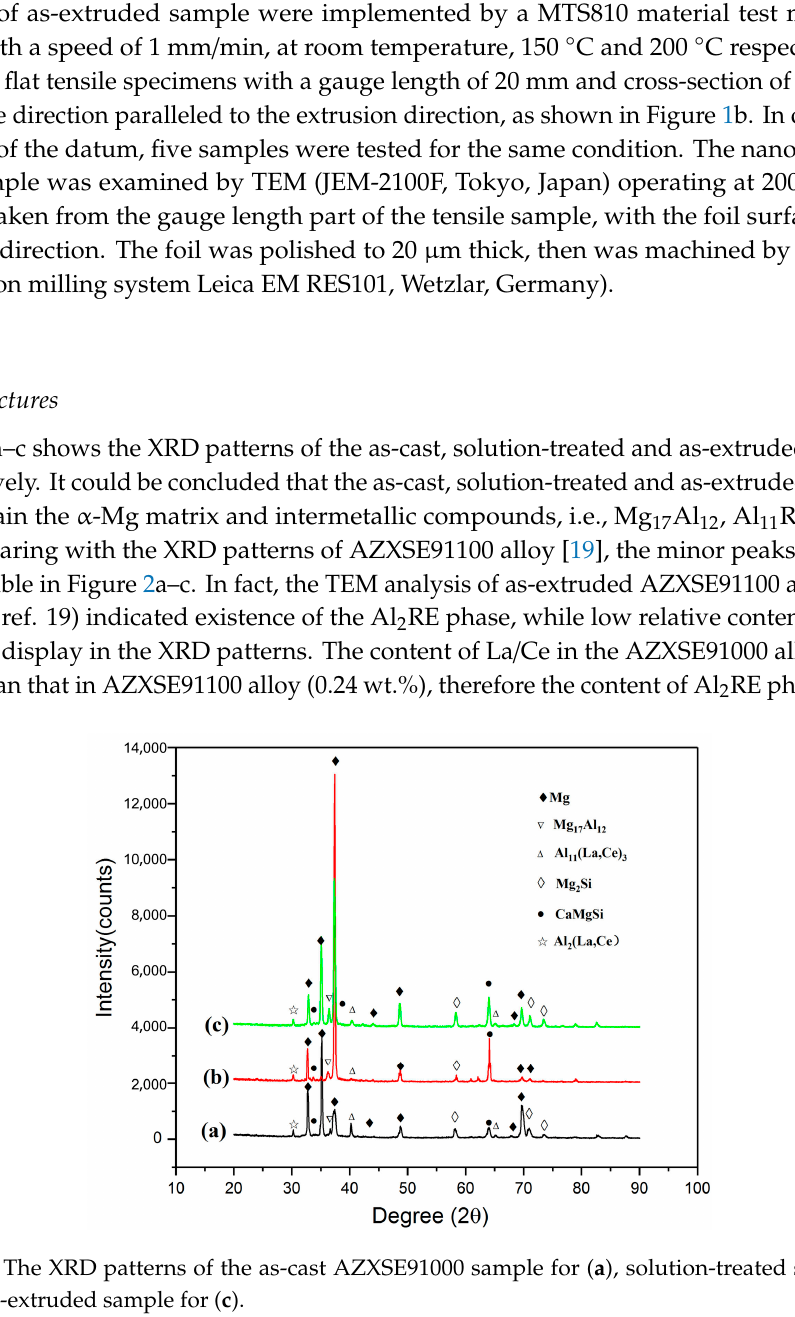
Figure 1. The mechanical drawing of the tensile creep sample and tensile sample (unit is millimeter).